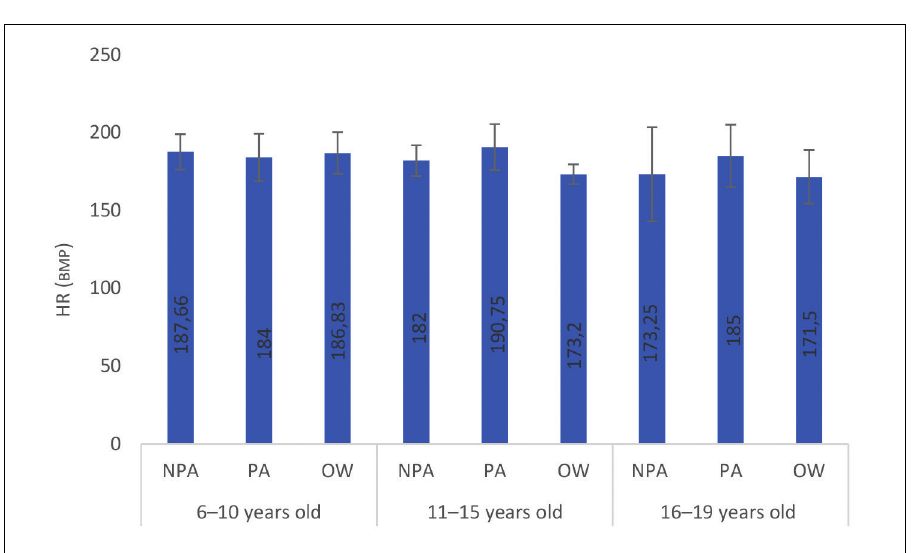
Figure 4. Heart rates